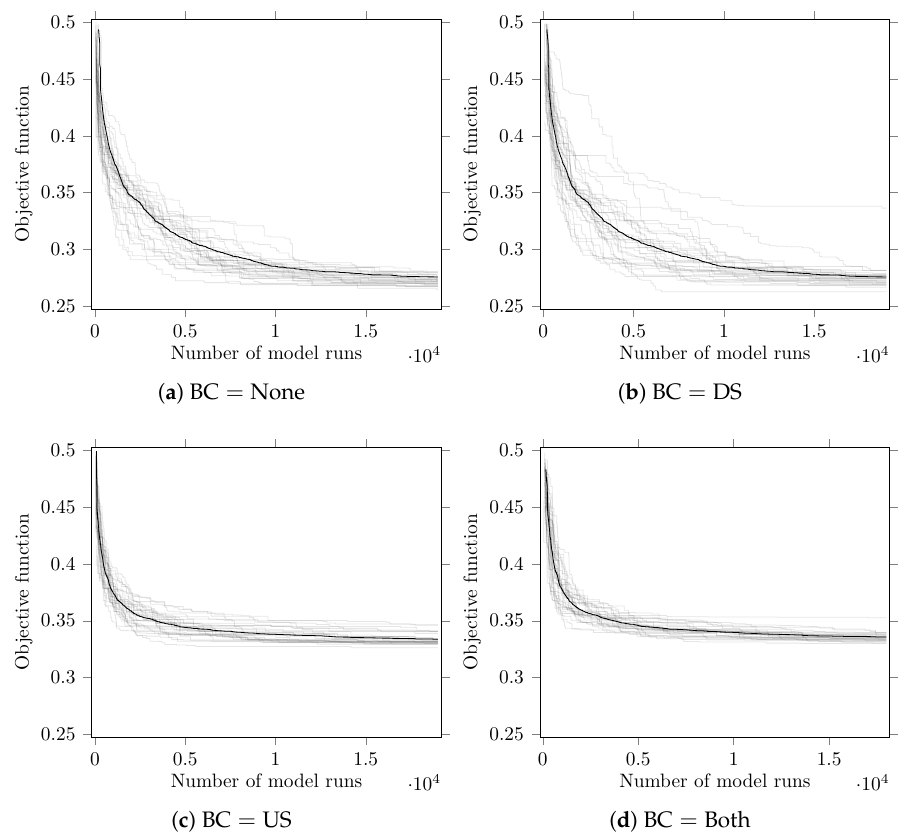
Figure 8. Cumulative minimum values of the objective function vs. the number of model runs. The gray lines and black line represent 30 runs of AFORAS and the mean of those runs,